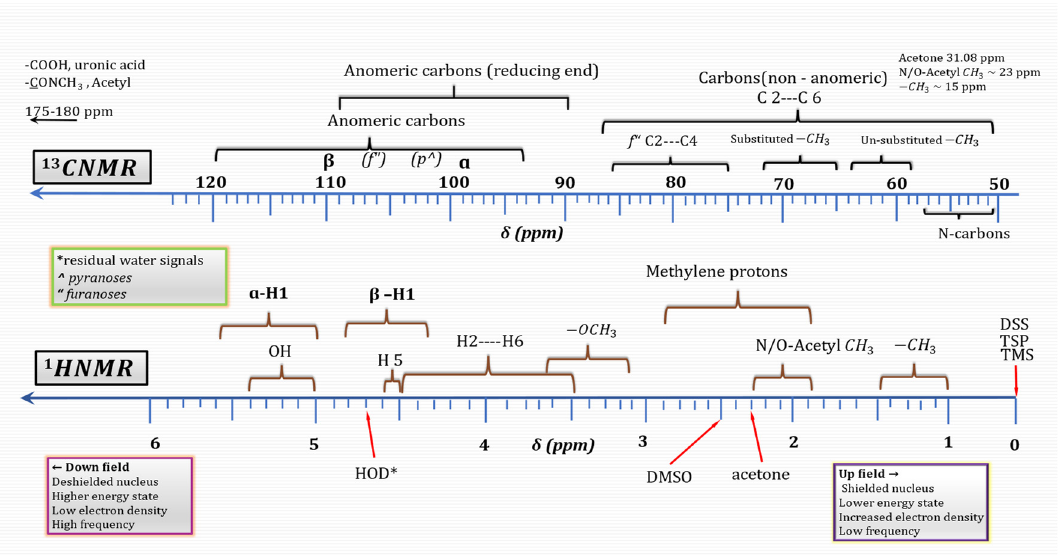
Figure 2. Carbohydrate predictable regions in 1 H and 13 C NMR spectra chemical shift assignments [60–62].